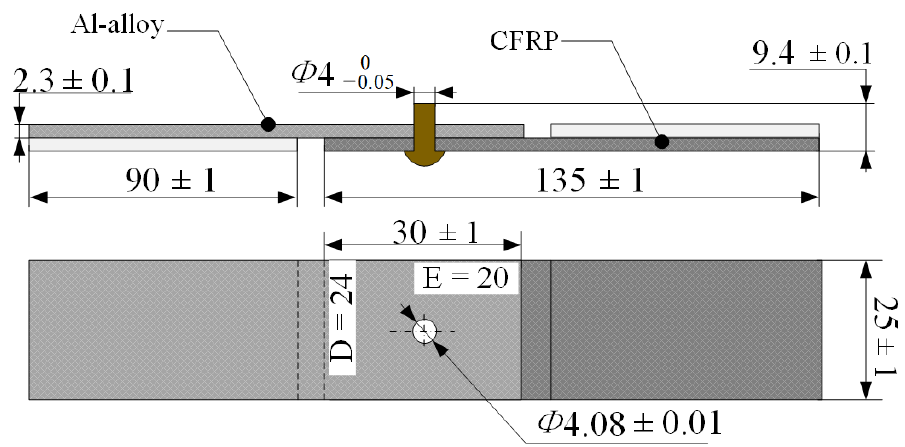
Figure 1. Dimensions of the riveted lap joints of CFRP laminates (dimensions in mm).